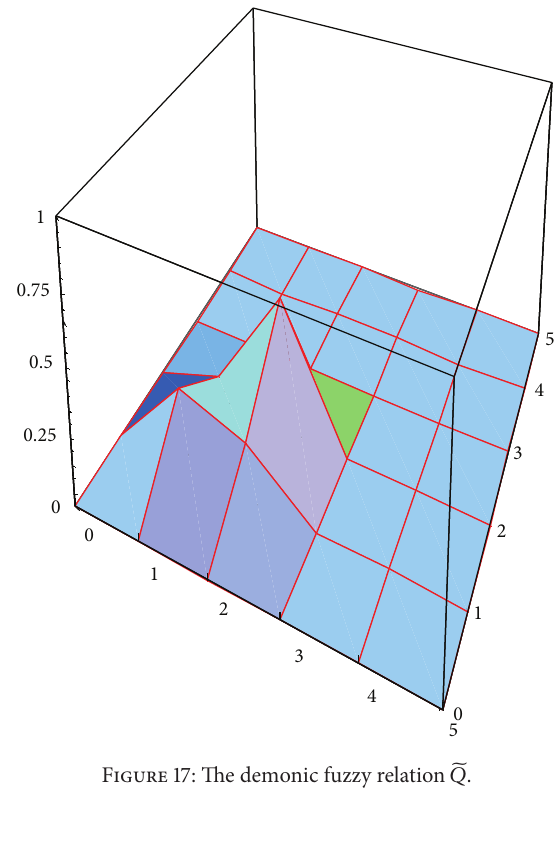
Figure 15: Demonic intersection of fuzzy relations